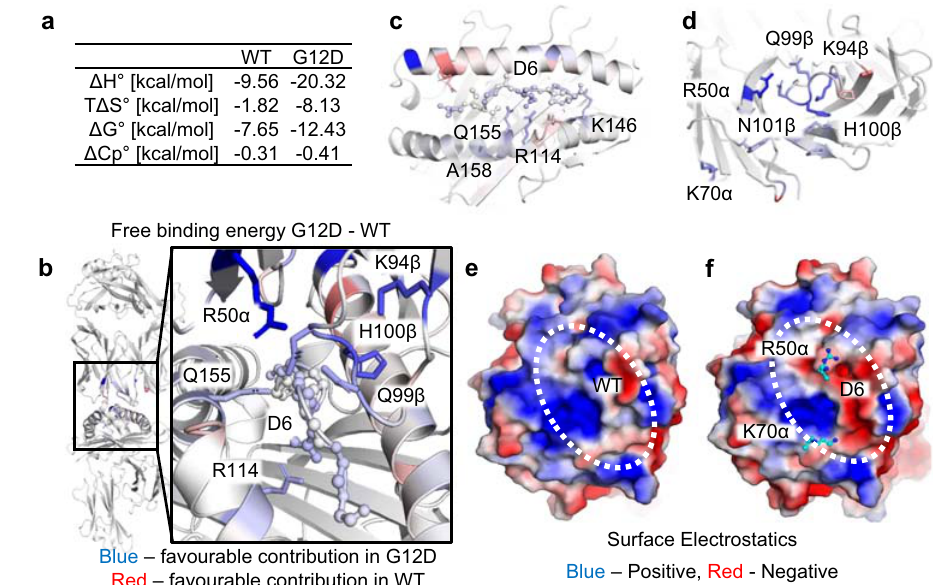
Fig. 3 | Difference in binding energy is primarily driven by changes in electro- staticpotentialinpHLAmediatedbytheD6mutation.a Enthalpy,entropy,and Gibb ’ s free energy values obtained from thermodynamic analysis. b – d Color mapping of the differences between JDIa41b1-HLA-A*11-KRAS G12D and -HLA-A*11- KRAS WT (G12D – WT)intermsofthecontributiontothebindingenergyperresidue, showingtheresidueswithhighercontributiontothebindingenergyinG12D(blue) and those with higher contribution in the WT (red). The scale is ±2kcal.mol-1. The peptide is shown as ball and sticks throughout and any residues with signi fi cant differences ( P <0.01) over ±0.25kcal.mol – 1 are shown as sticks. Key residues are